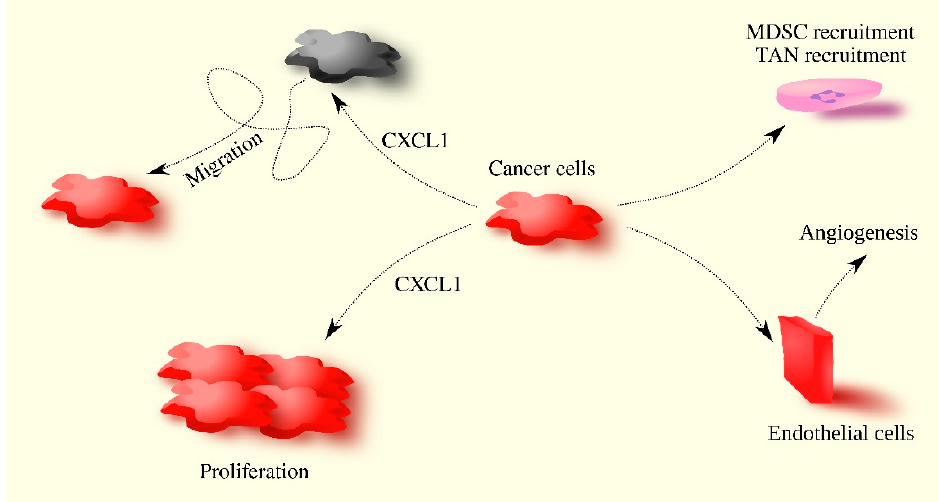
Figure 1. CXCL1’s involvement in cancer processes. CXCL1 increases proliferation and migration, and also acts on tumor-associated cells. CXCL1 recruits neutrophils, MDSCs, and induces angiogenesis.